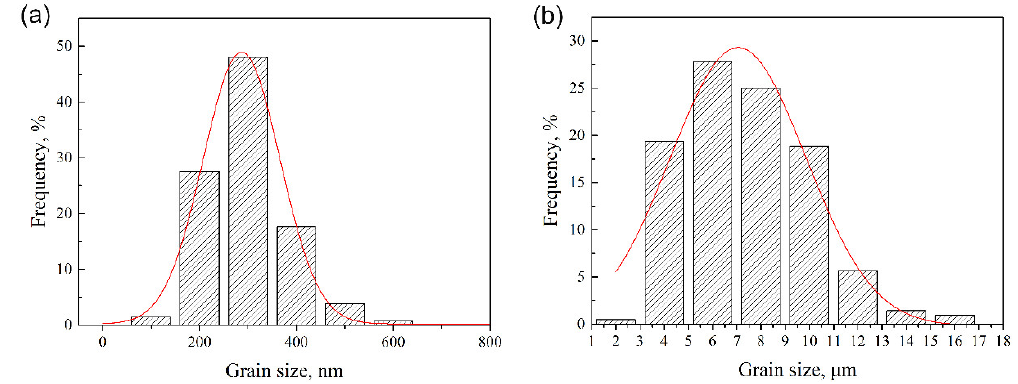
Figure 3. Size distribution of ( a ) submicron and ( b ) micron grains in the as-spark plasma sintered (SPSed) sample.